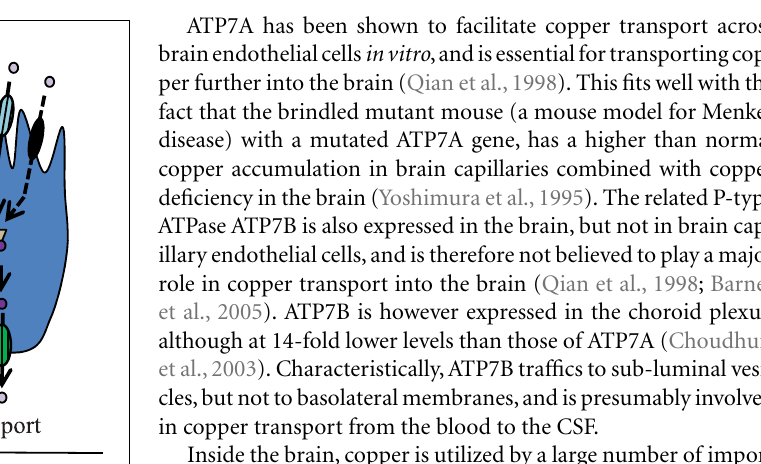
transporterexpression.Thebulkof